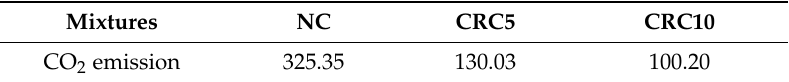
Table 4. CO 2 emission of concrete (kg / m 3